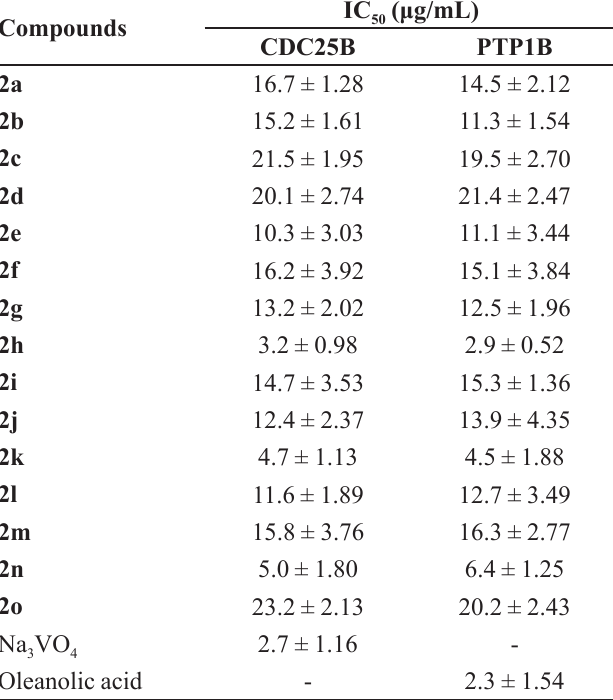
TABLE I - Inhibitory activity of compounds 2a-2o against CDC25B and